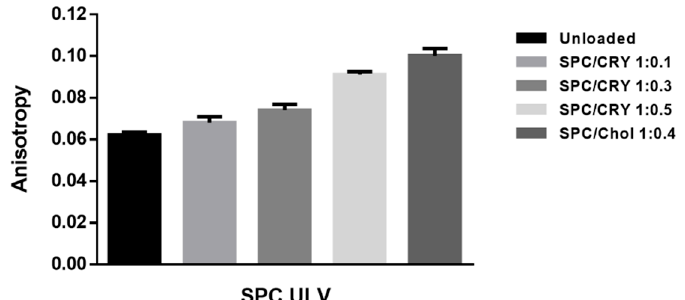
Figure 9. Anisotropy measures obtained by DPH-probe fluorescence for 1:0.1, 1:0.3 and 1:0.5 SPC/CRY ULV and 1:0.4 SPC/cholesterol (Chol) ULV.